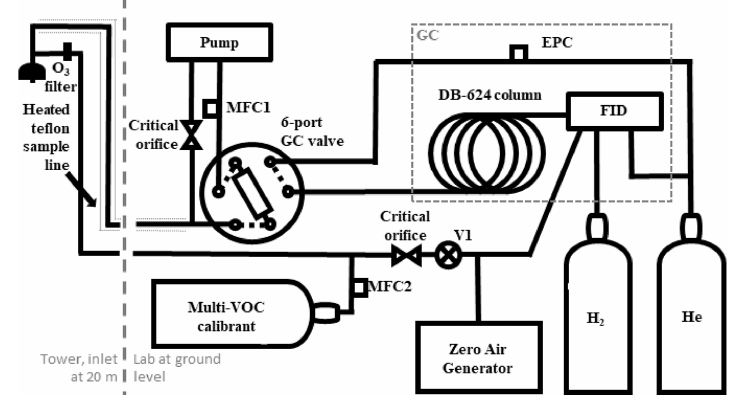
Figure 1. A schematic of the VOC-GC-FID set up at the Virginia Forest Research Lab. MFC, mass flow controller; V1, valve; GC, gas chromatograph; FID, flame ionization detector; EPC, electronic pressure controller; He, helium gas; H 2 , hydrogen gas. Small, dashed lines around the inlet denote the portion that is heated. The large dashed grey line denotes the indicates that the inlet is within the canopy and the rest of the instrument is in the shed, and the boxed-in dashed grey line denotes the components that are part of the